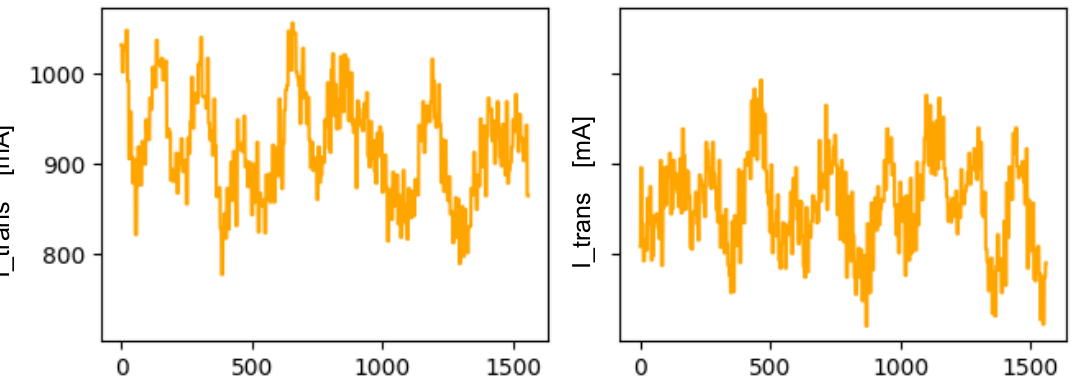
Figure 13. Comparison of the Vaux tension measurements of a 5 € banknote on reverse back orientation in the case of normal operation ( left ) and a failure case ( right ).